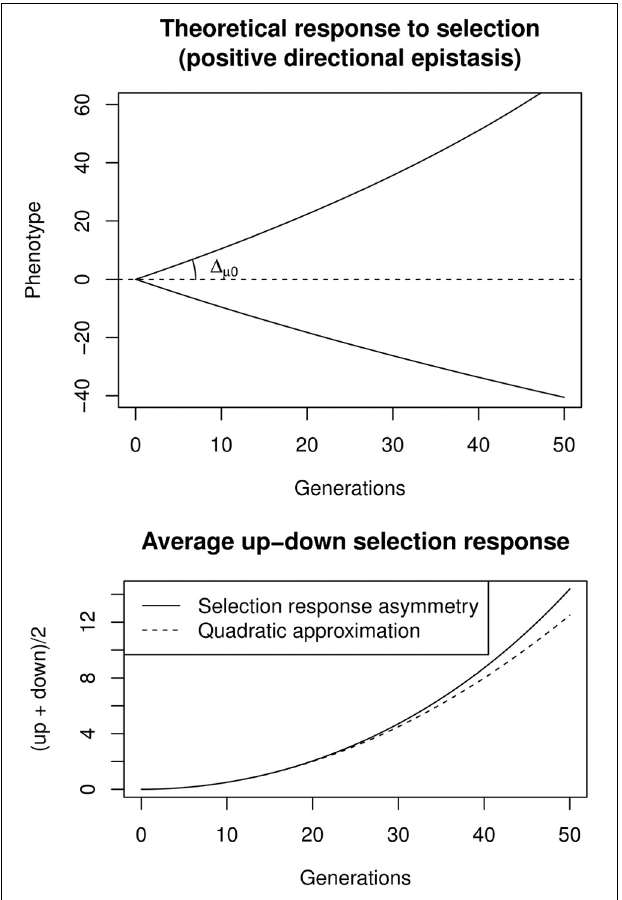
FIGURE 3 | Top: Theoretical response to bidirectional constant selection under positive directional epistasis ( ε = + 0 . 005, (cid:4) μ selection response is asymmetric, and the up-down average increases almost quadratically with time, the quadratic coefficient being ε(cid:4) 2 μ